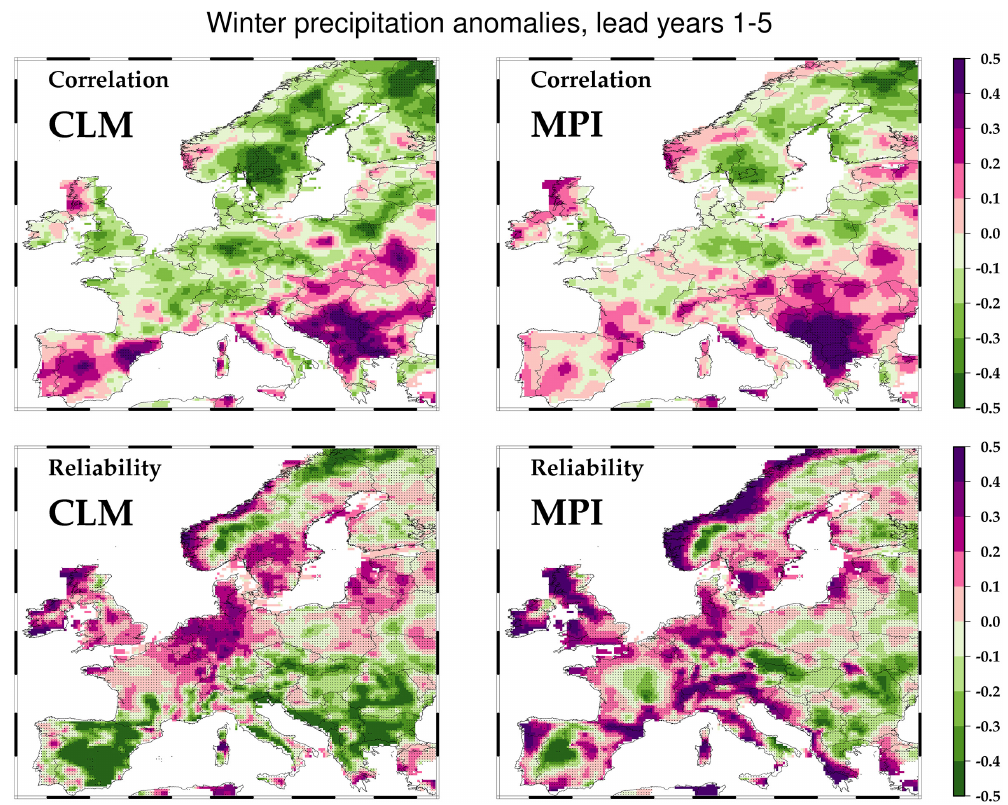
Figure 7. Winter half-year precipitation anomaly sums for lead years 1–5 from 1961 to 2010. The top panels show the correlation coefficient between E-OBS observations and CCLM (left) and MPI-ESM-LR (right). The bottom panels show the reliability of the CCLM (left) and MPI-ESM-LR (right) ensembles with respect to the E-OBS observations. Stippling indicates results, significant at the 10%